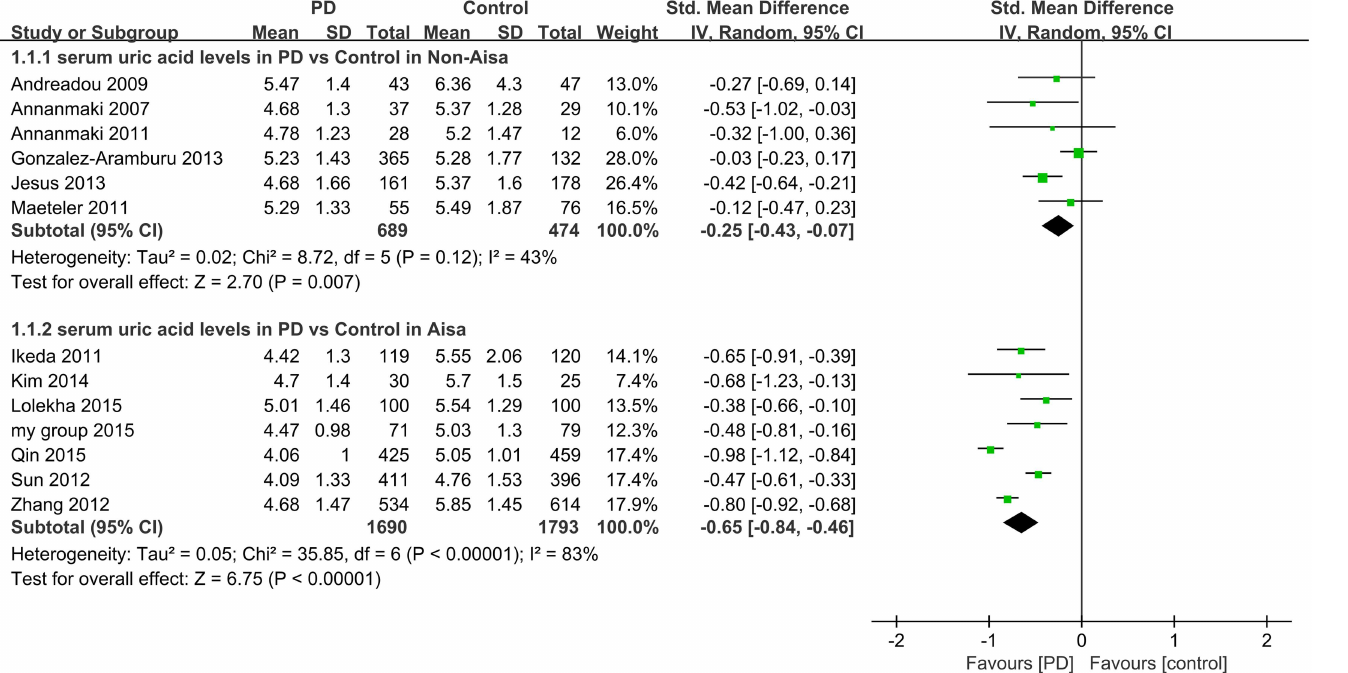
Fig 3. Forest plot of serum uric acid levels in PD compared to control in Asia and Non-Asia groups.